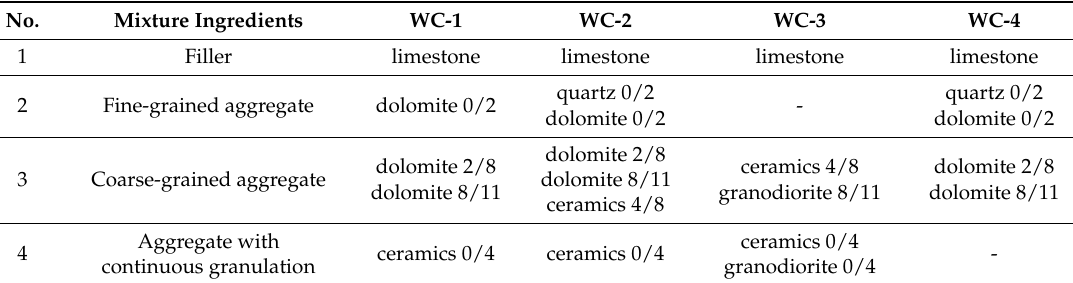
Table 4. Composition of mineral mixtures for series